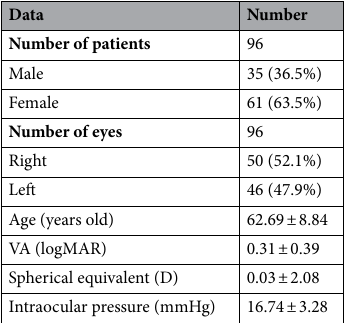
Table 1. Number of patients and demographic data.